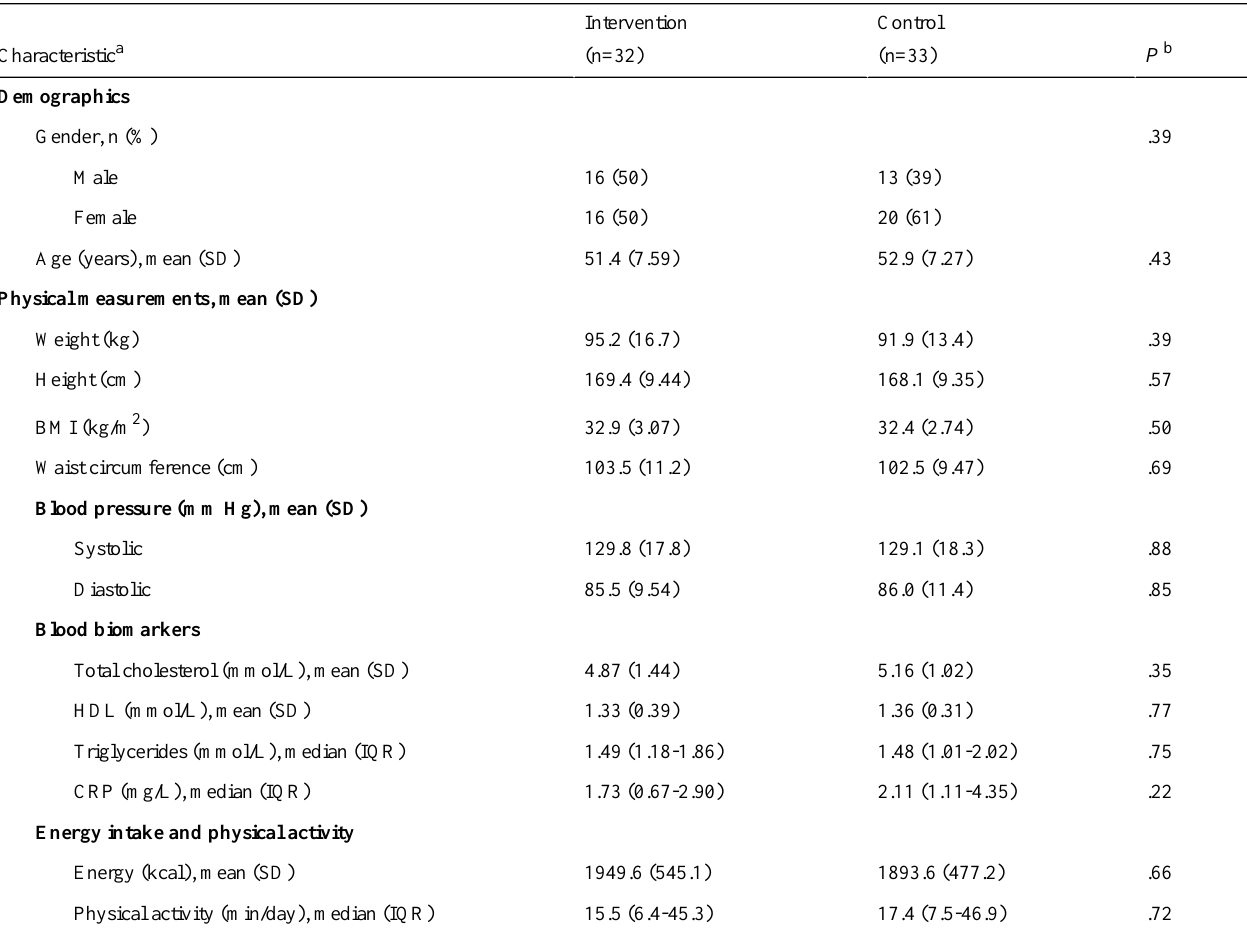
Table 2. Baseline characteristics of intervention and control participants according to control and intervention